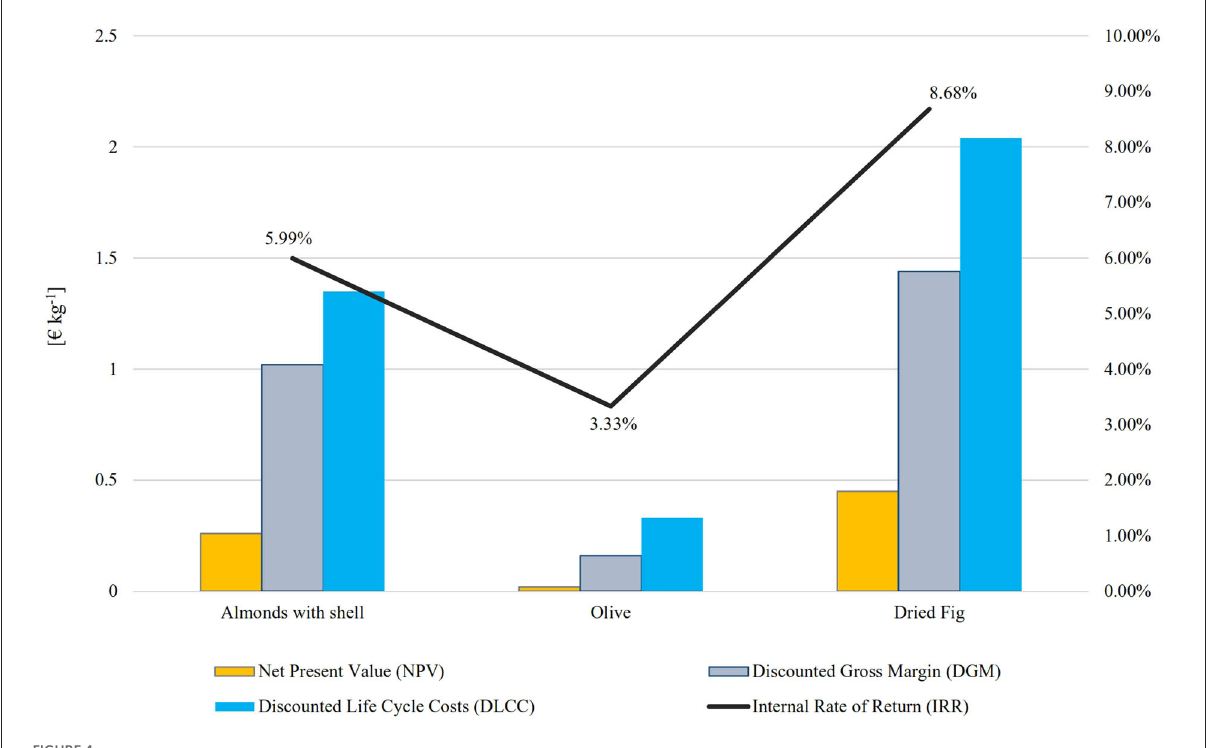
FIGURE4 Investment analysis results (Source: Authors’